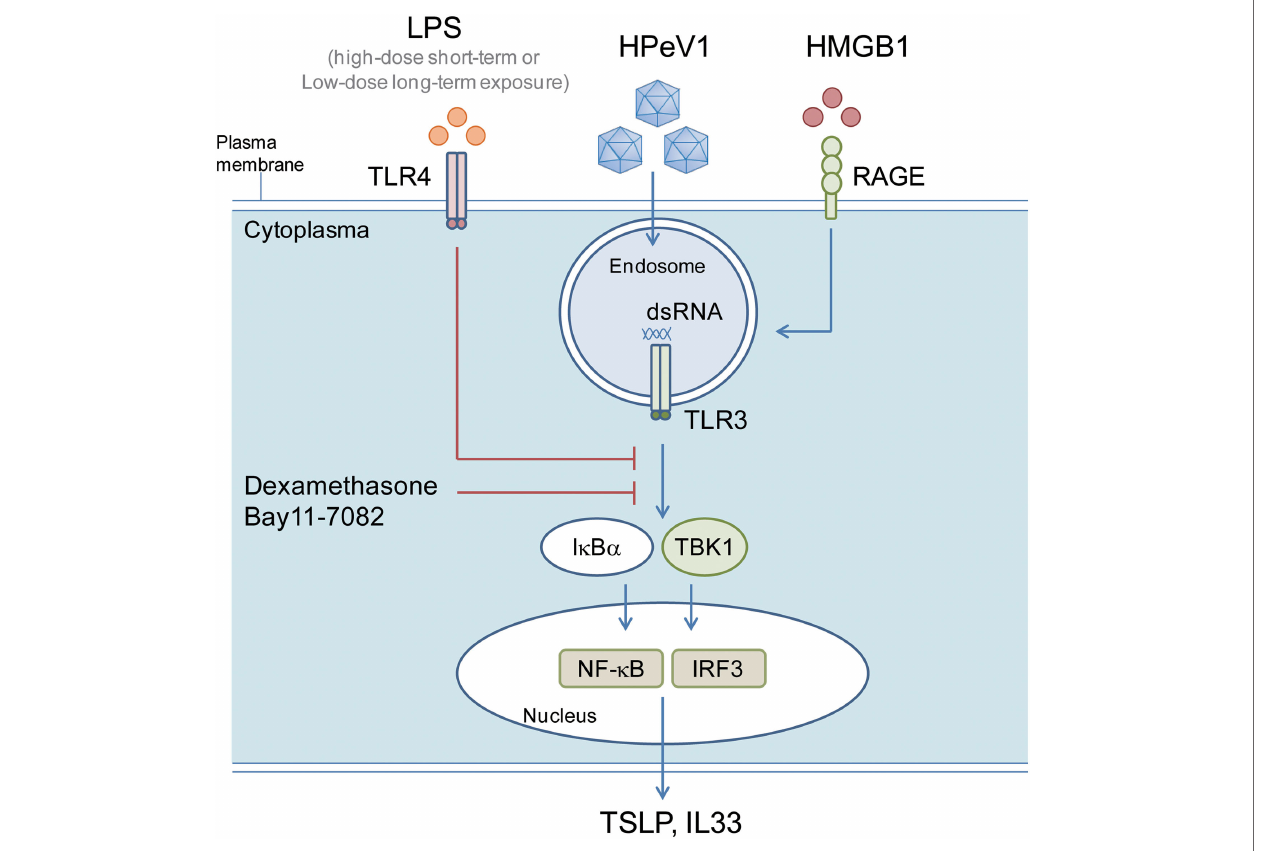
FigUre 9 | lPs inhibits polyi:c- and virus-induced proallergic cytokines expression via targeting TBK1, irF3, and nF- κ B response . A schematic model shows the possible mechanism of the LPS modulating TSLP and IL33 in airway epithelial cells. The polyI:C or HPeV1 activated TLR signaling is inhibited in the cells with short- and long-term LPS exposure, or inhibitors (Dexamethasome and Bay11-7082) treatment, which lead to a defective expression of TSLP and